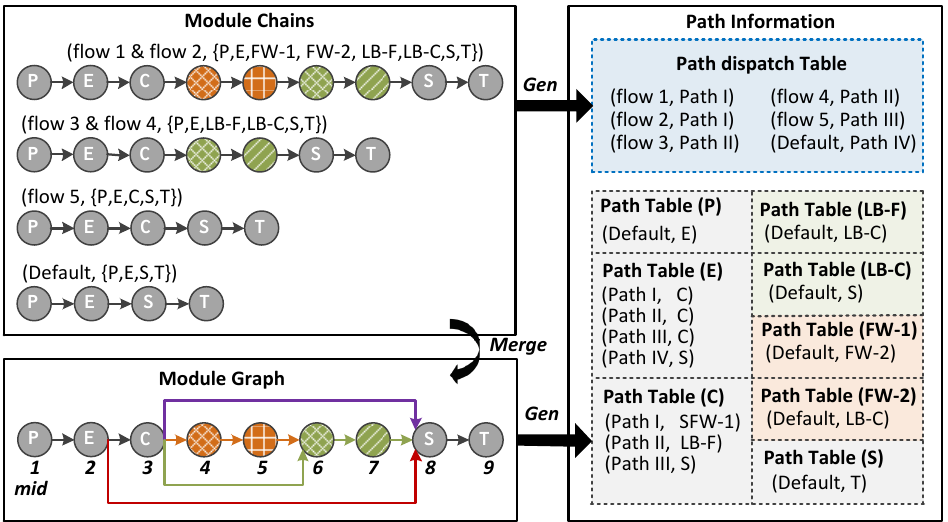
Figure 9. PMI compiler uses module chains to generate the module graph, and uses module chains and the module graph to generate the path information (configuration of path dispatch and path tables).